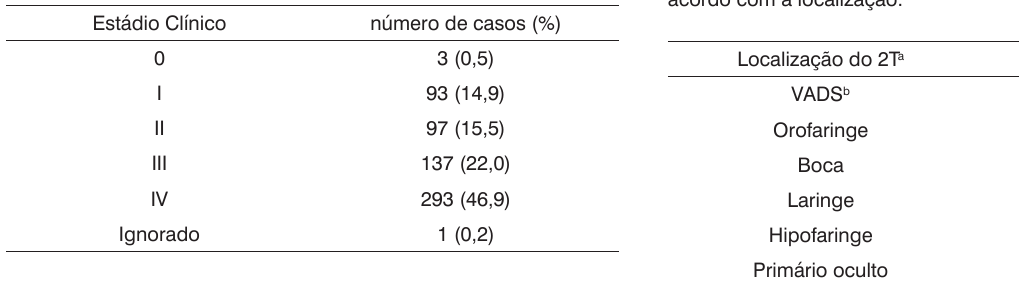
Tabela 2. Estadiamento clínico dos 624 tumores primários.